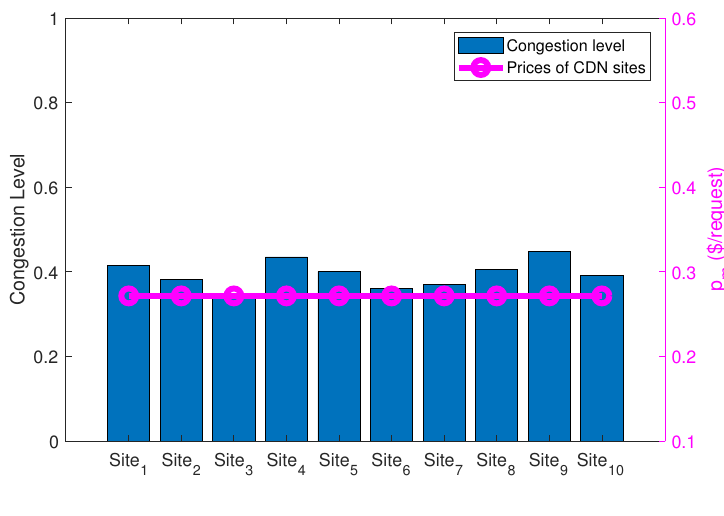
Figure 6. LDP prices in Traffic Pattern 3.